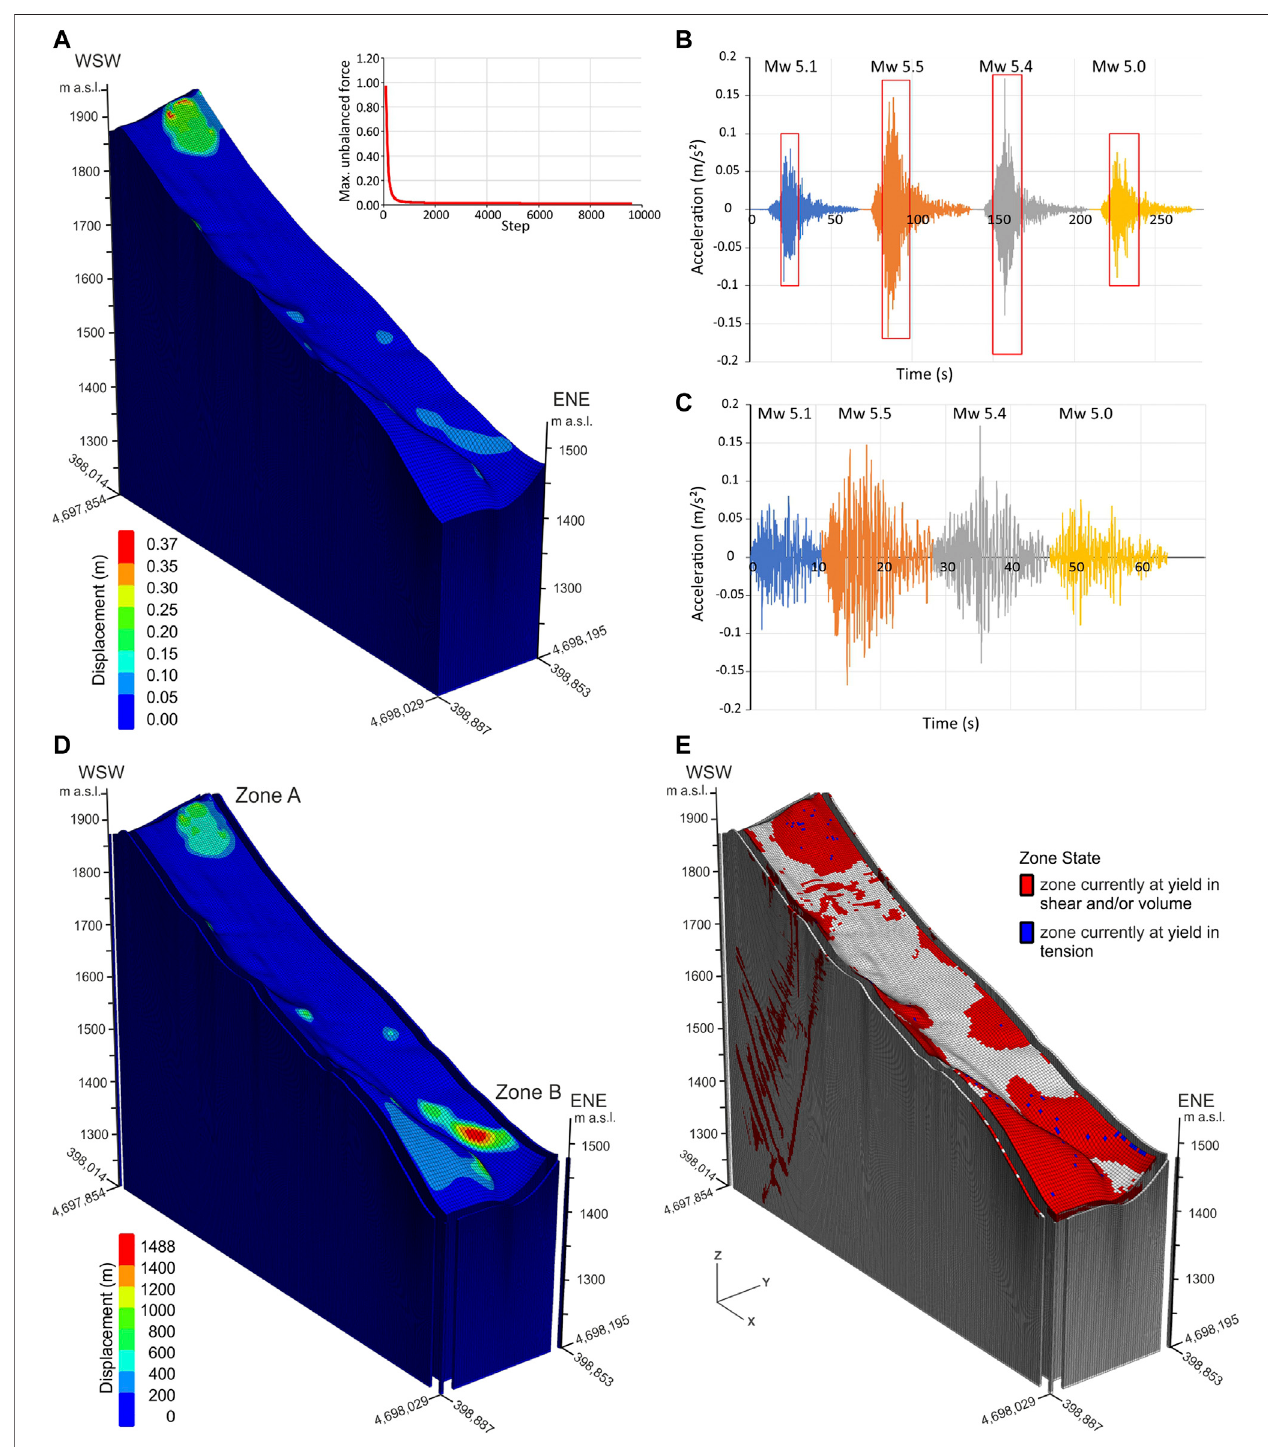
FIGURE 13 | (A) Zone displacement magnitude predicted by the FLAC3D simulation run under static conditions with 3 m of snow; in the upper right maximum unbalancedforcegraph. (B) Thesequenceoftheaccelerograms(CapestranoAccelerometricStation(Luzietal.,2017); Figure5 )oftheMw > 5earthquakesonJanuary 18, 2017. The red boxes show the signi fi cant sections of the four accelerograms. (C) Signi fi cant sections of the four accelerograms combined to de fi ne the input of the second analysis. (D) Displacement magnitude and (E) plastic state predicated by the FLAC3D simulation run under dynamic conditions with 3 m of snow; the images were extracted at the end of the simulation (input in B